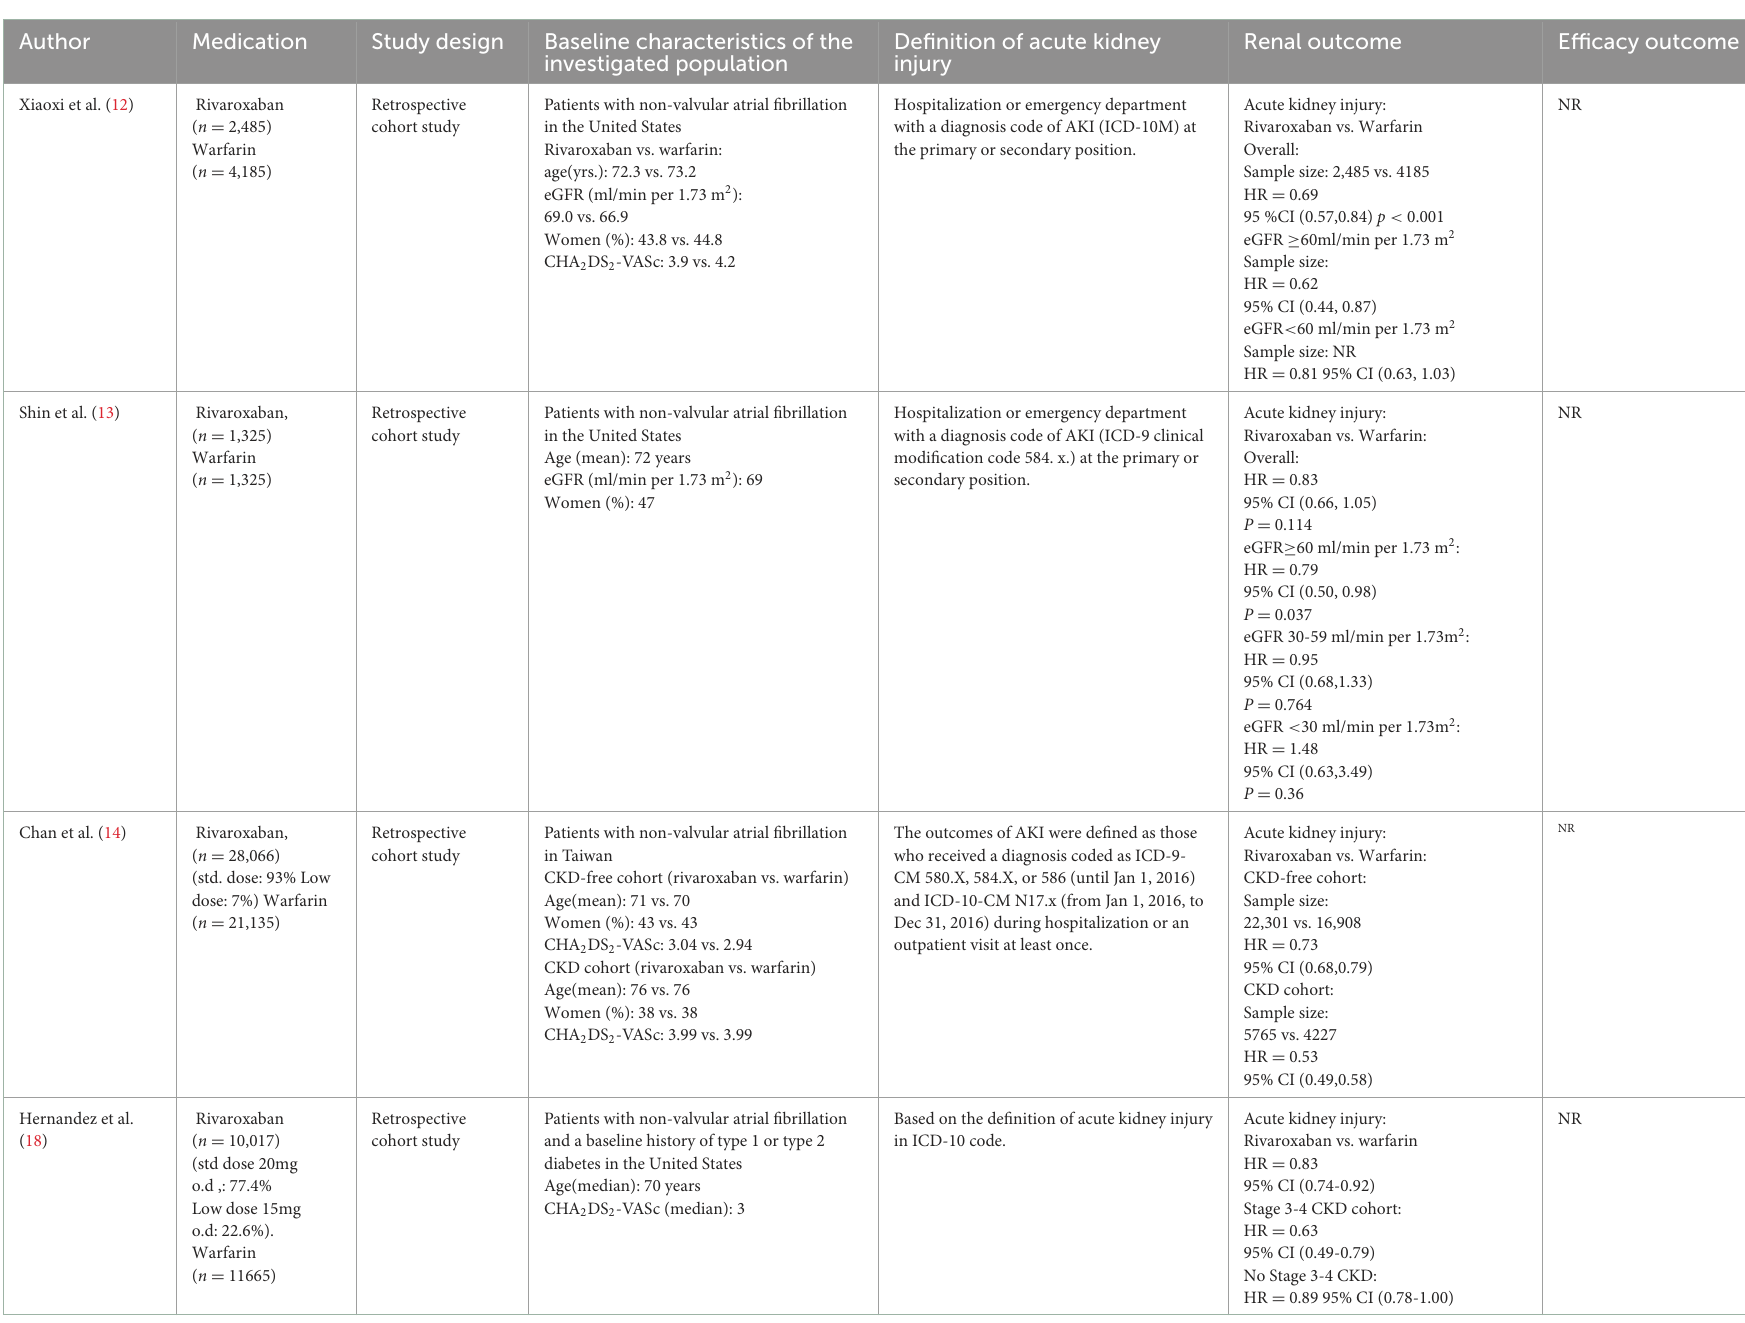
TABLE 3 Summary of studies comparing the risk of AKI induced by rivaroxaban and